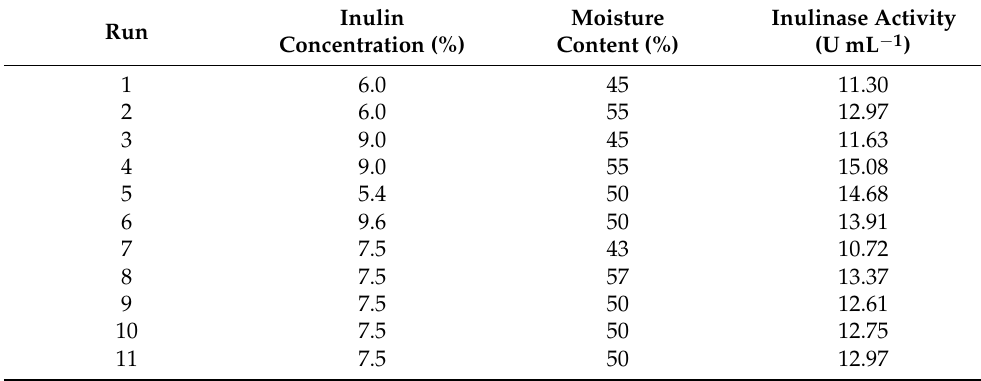
Table 4. Experimental conditions and results of inulinase production by Aspergillus terreus URM4658 in solid-state fermentation using wheat bran as substrate. Runs were performed according to a central composite rotational design.